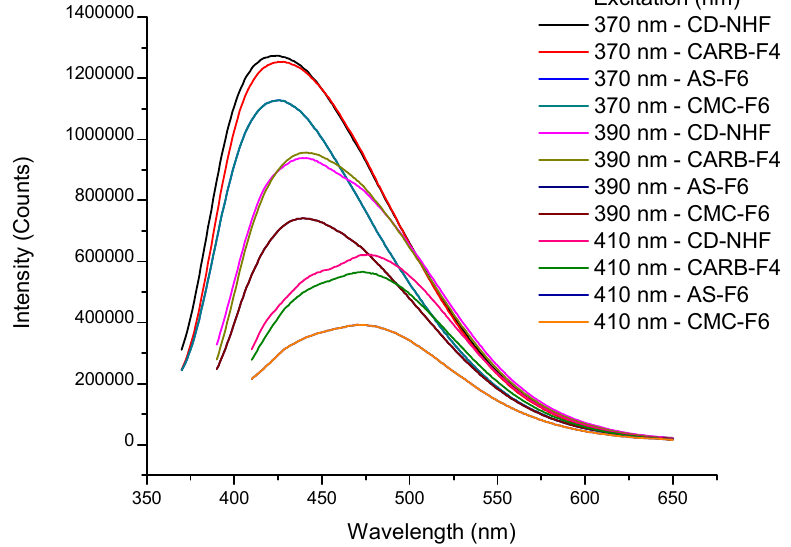
Figure 4. Emission spectra of CD-NHF suspended in H 2 O: CARB-F4, AS-F6, and CMC-F6 samples.